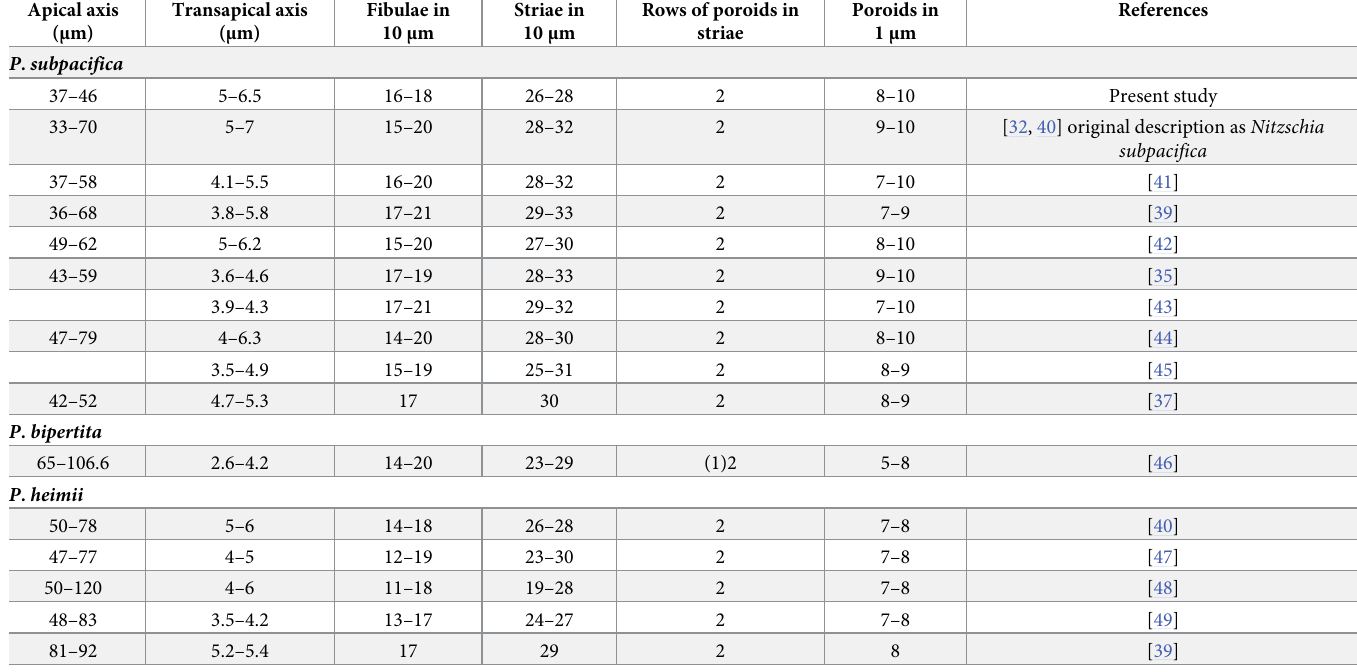
Table 1. Morphometric measurements of Pseudo-nitzschia subpacifica in the present study, compare to previous reports. Each species listed possesses a central nodule. Apical axis ( μ